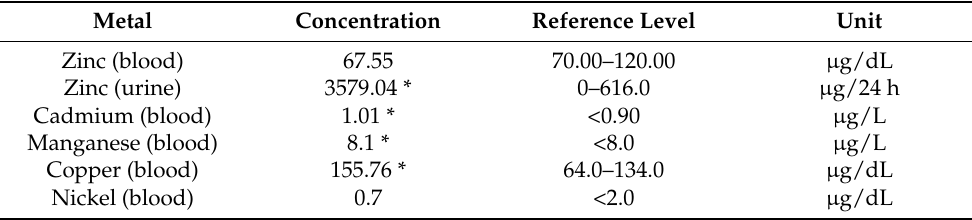
Table 2. Serum and urine metal concentrations (sampled on day 5 of admission).